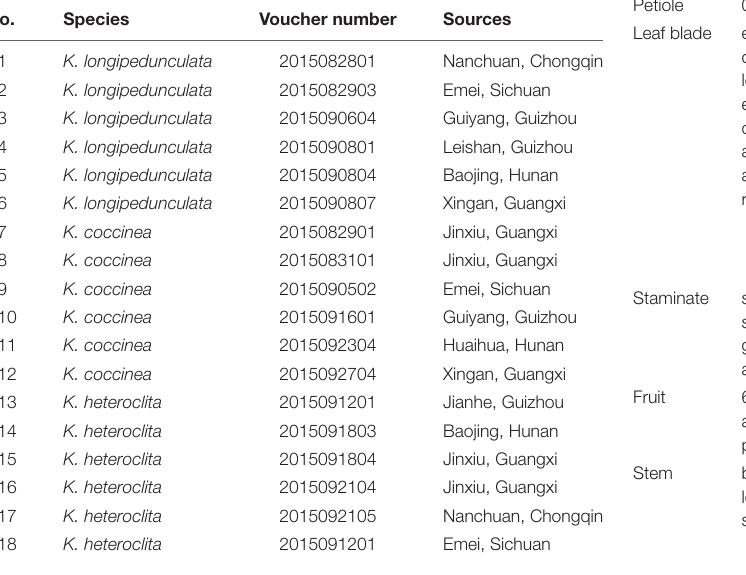
TABLE 1 | Samples of K. longipedunculata , K. coccinea , and K. heteroclita .